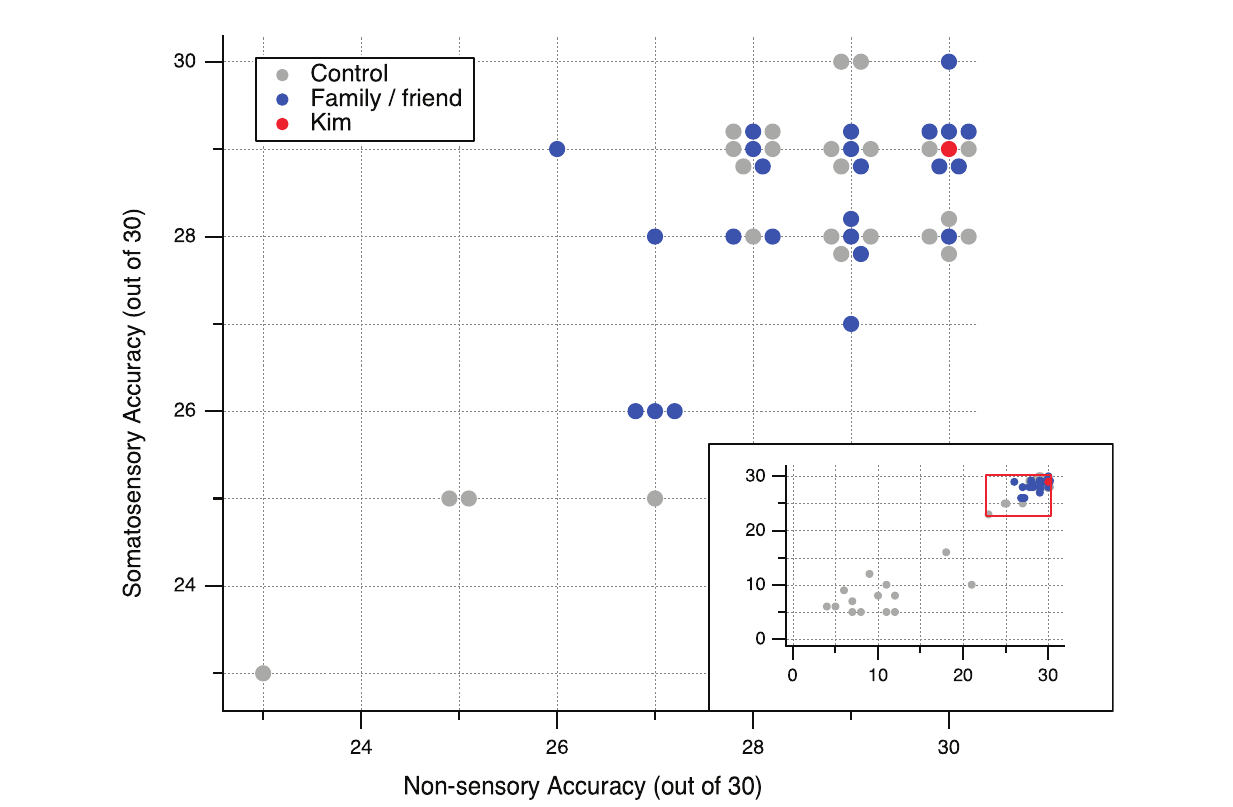
FIGURE1 Number of expressions accurately selected given the context for the non-sensory (x-axis) and tactile (y-axis) expressions. The number 30 indicates that the accurate and anticipated expression was selected for every vignette, while 7.5 indicates performing at chance. The inset illustrates accuracy for all participants who passed the attention checks, but the primary pane focuses on the attentive participants performing well above chance. Note that Kim (in red) and all the direct-recruited friends and family of Kim (in blue) are performing near ceiling.